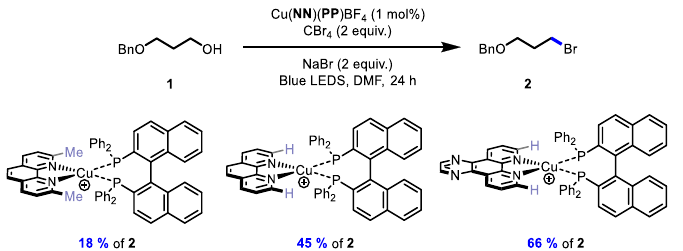
Figure 4. Effects of the diimine ligand of heteroleptic copper complexes in a photochemical Appel- type process.